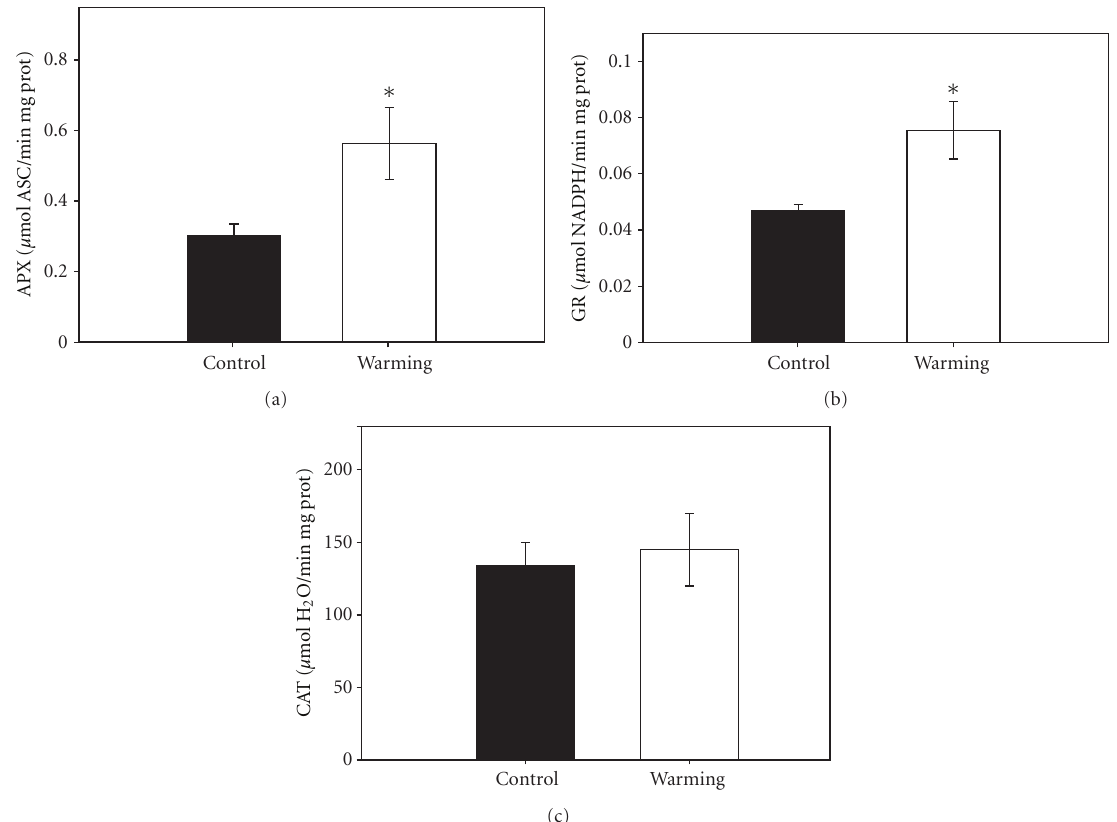
Figure 4: Activities of antioxidant enzymes related to the leaf protein content: (a) ascorbate peroxidase, (b) glutathione reductase, and (c) catalase (all expressed as μ molmin − 1 mg − 1 protein) in poplar control leaves and in leaves exposed to “warming.” Mean ± SE is shown for Populus x euramericana grown in a hydroponic system with water at di ff erent temperatures at 50 days after start of treatment. Di ff erences between means of control and “warming”—treated leaves are shown. ∗ P ≤ 0 . 05, ∗∗ P ≤ 0 . 01, ∗∗∗ P ≤ 0 .